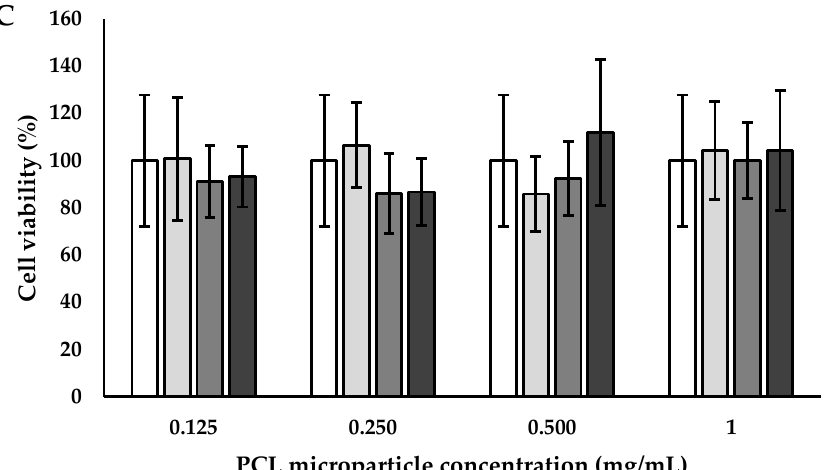
Figure 9. Cell viability of endothelial cells grown for ( A ) 24, ( B ) 48, and ( C ) 72 h in the presence of PCL MPs. PCL: poly( ε -caprolactone).